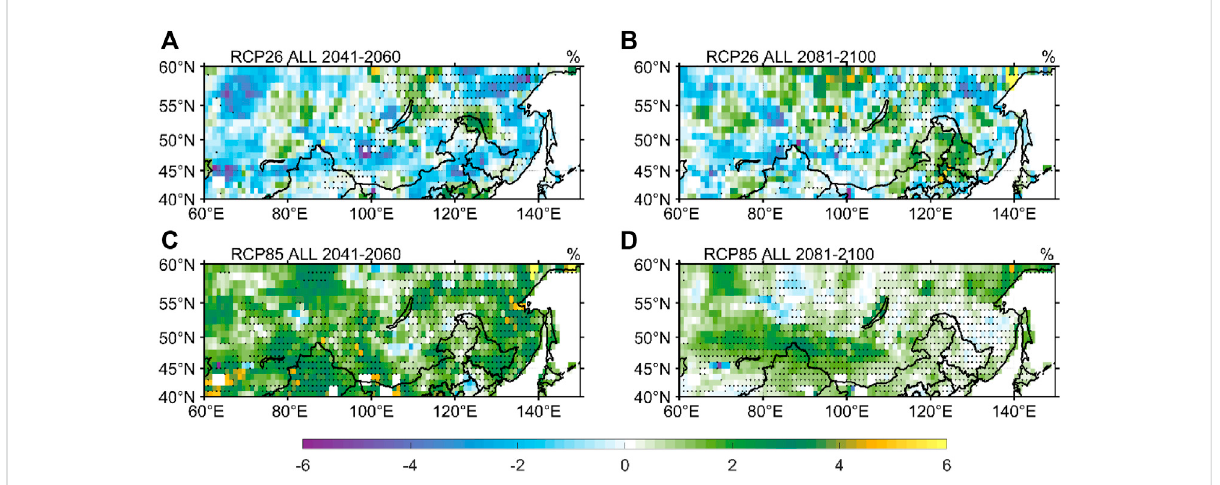
FIGURE 5 Ensemble projected percentage anomalies (%) of EHE-GPP relative to the climatological state during (A,C) the mid-century and (B,D) the end- century under (A,B) RCP2.6 and RCP8.5 (C,D) from the ALL simulations. Regions with six out of seven models exceeding the 95% signi fi cance level are